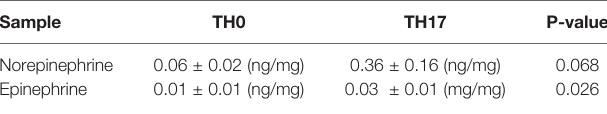
TABLE 1 | Epinephrine and norepinephrine level in T cells. Sample